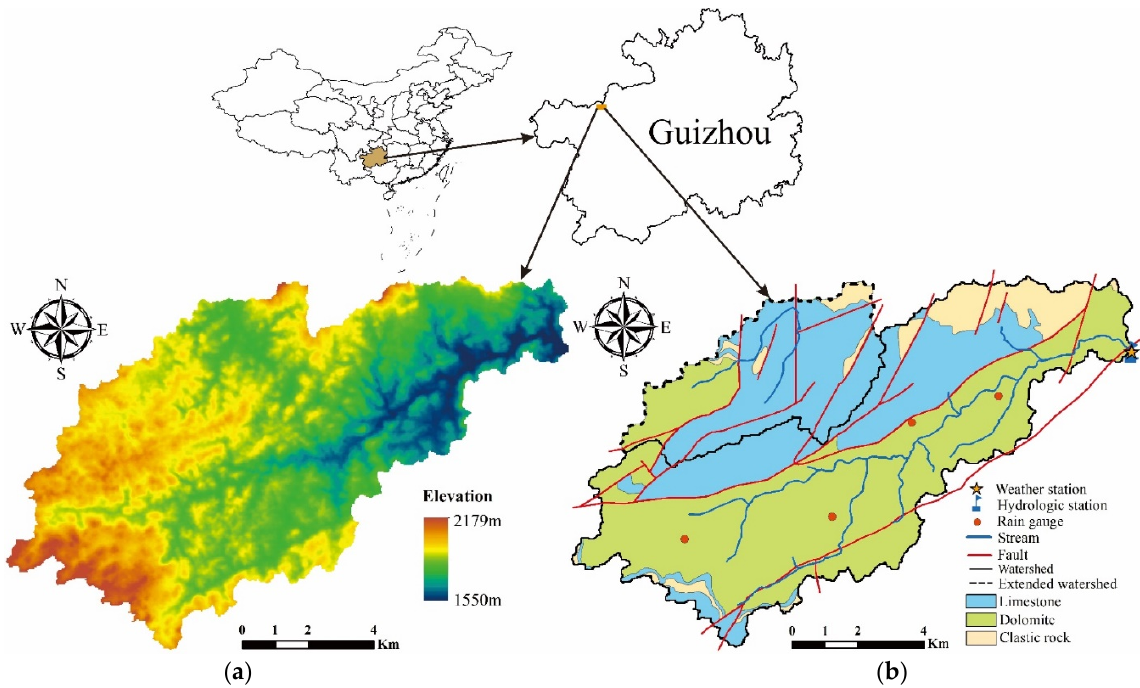
Figure 1. ( a ) DEM of the Daotian River watershed, ( b ) Geological map of the Daotian River watershed (extracted from the comprehensive hydrogeological map of Bijie area, China).